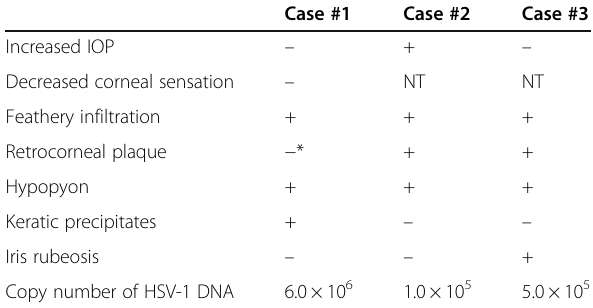
Table 1 Summarized results of ophthalmologic